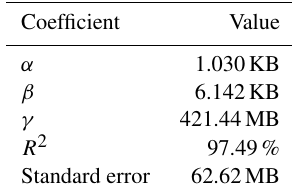
Table 7. Estimation of the memory model coefficients. The evalu- ation has been experimentally performed considering a decomposi- tion made up of 19 × 45 subdomains, with 183 of them having land points only (672 parallel processes have been used for the simula- tion). Coefficient Value